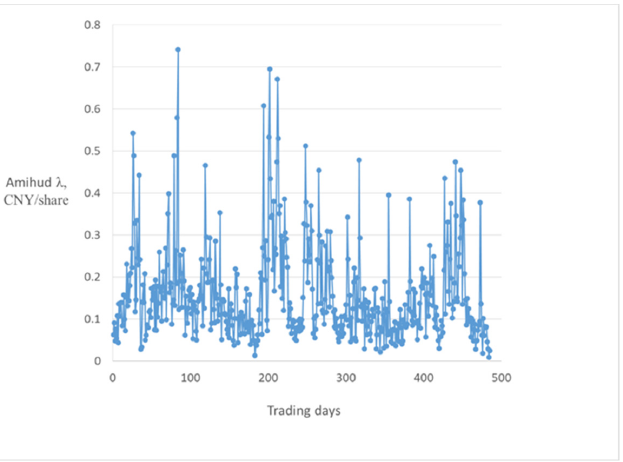
Figure 7. Time series of average Amihud λ (Equation (9)) across all price buckets for a single